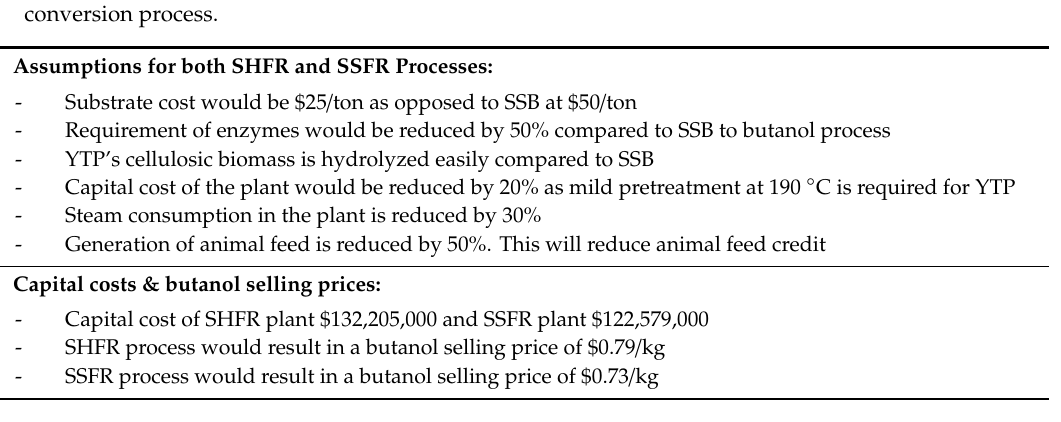
Assumptions and butanol selling price for yellow top presscake (YTP)-to-butanol conversion